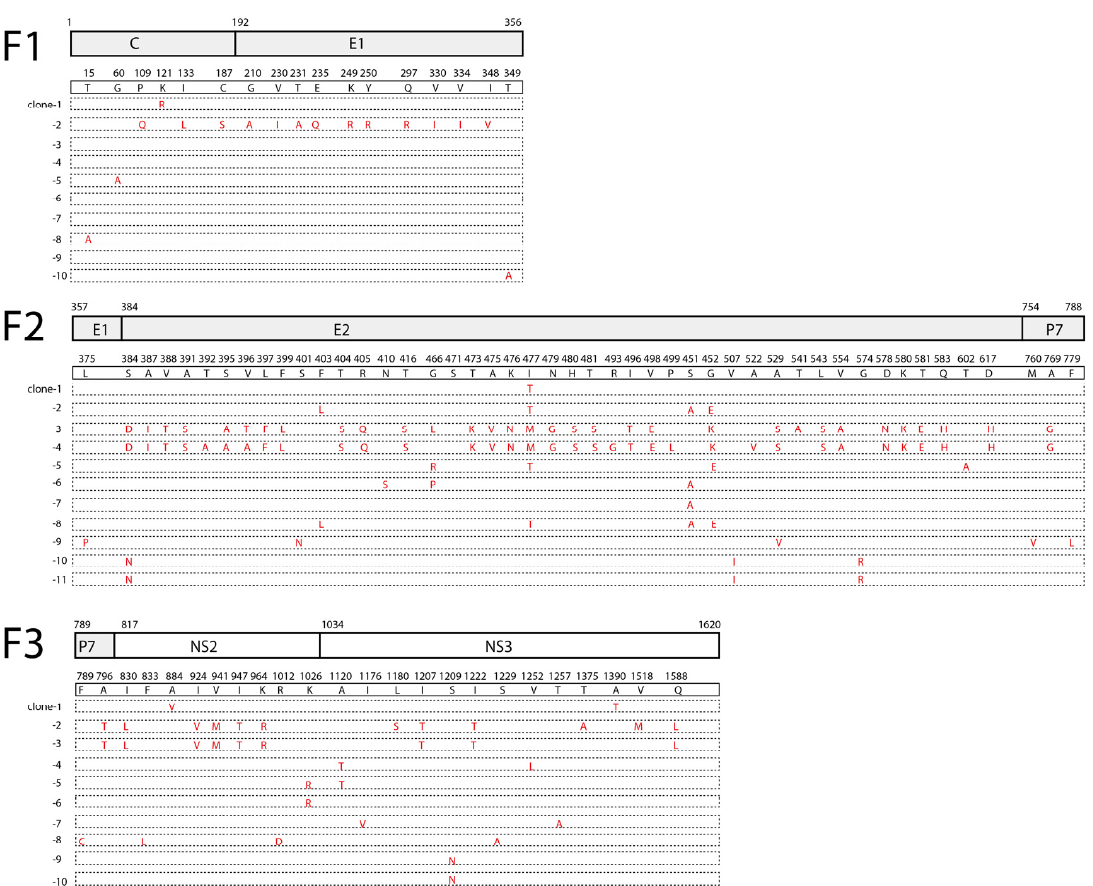
Figure 3. Sequence profile of HCV genome fragments − I. As described above, for each amplified fragment, the fragment was cloned, and at least ten colonies were sequenced. Each dashed box indicates a sequenced cloned fragment. The amino acids different from the consensus sequence in each sequenced clone are indicated (red). The positions of the amino acids are indicated. Each cloned fragment and the contained viral proteins (C, E, E2, p7, NS2, and NS3) and their corresponding amino acid positions are indicated.